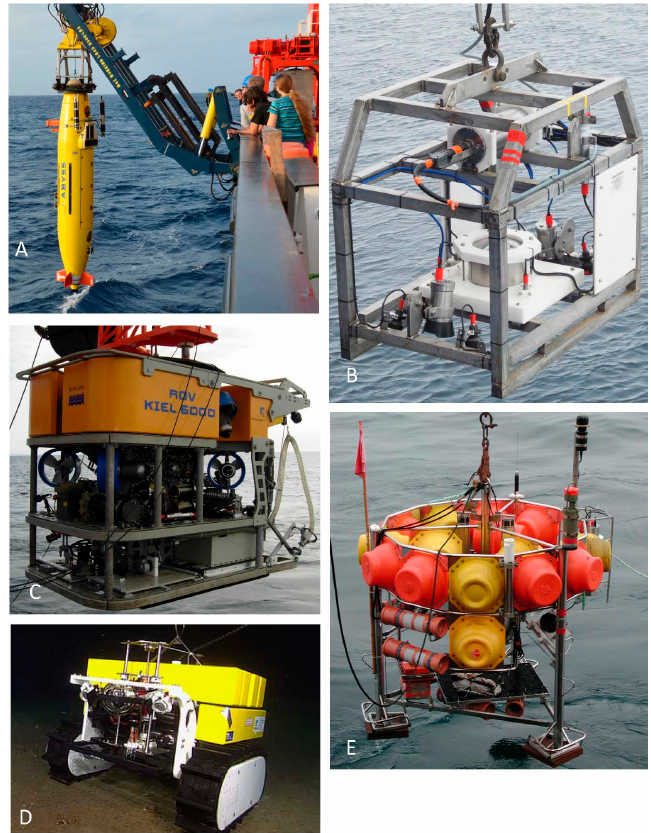
Figure 2. ( A ) Autonomous Underwater Vehicle (AUV ABYSS); ( B ) Ocean Floor Observing System (OFOS); ( C ) Remotely-Operated Vehicle (ROV Kiel 6000); ( D ) teleoperated crawler of ONC (Ocean Networks Canada: http://www.oceannetworks.ca); ( E ) stationary lander system (these can also be equipped with baited traps, as shown in the image).